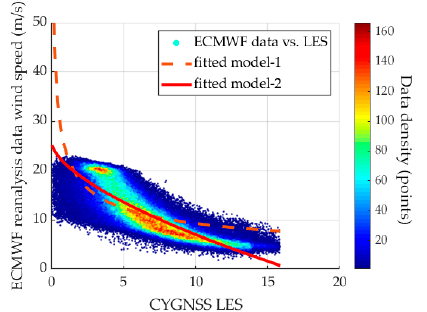
Figure 9. Scatter plot of leading edge slope (LES) versus ECMWF reanalysis data. The color bar represents the density of the data. In Model-1, the values of G and M are 23.64 and − 0.4064, respectively. In Model-2, the values of G , M, and L are: − 4.308, 0.6333, and 25.5, respectively.